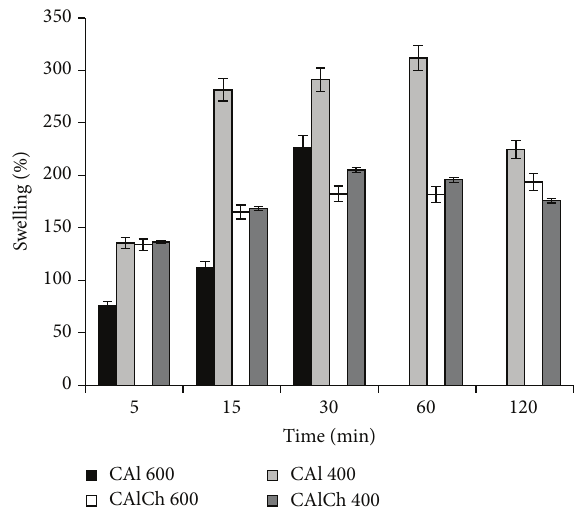
Figure 4: Swelling degree in phosphate buffer at pH 6.8.